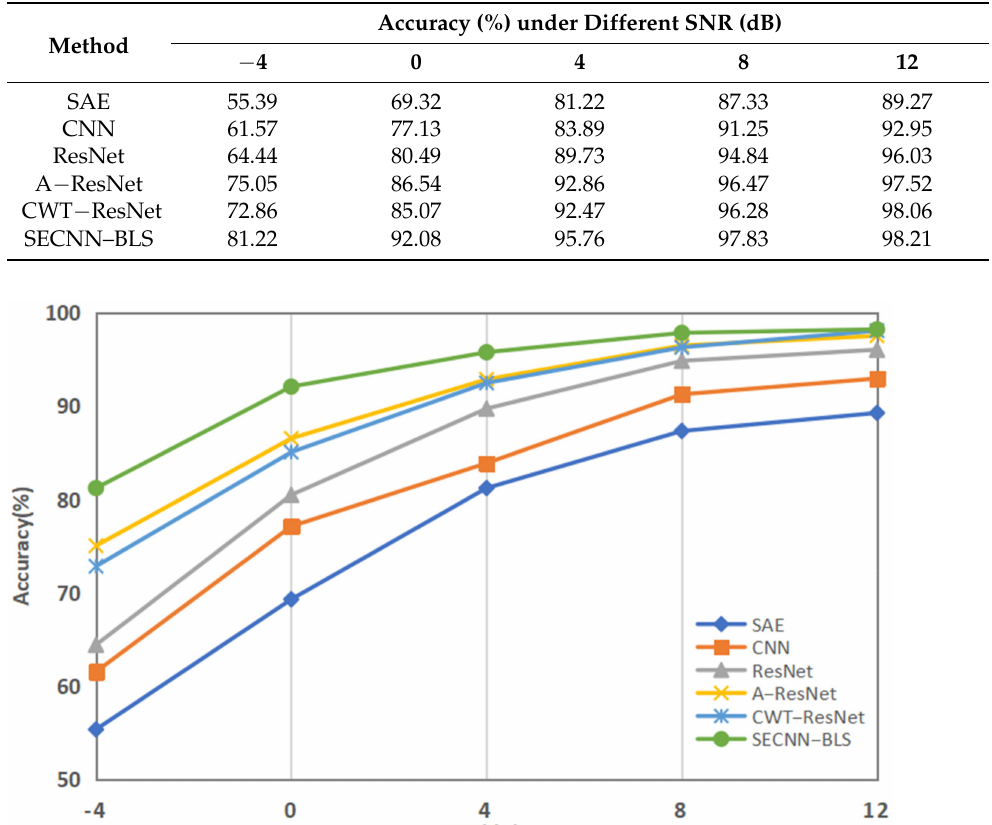
Table 4. Comparison results of fault diagnosis accuracy under a noisy environment with other methods on the MFPT dataset.